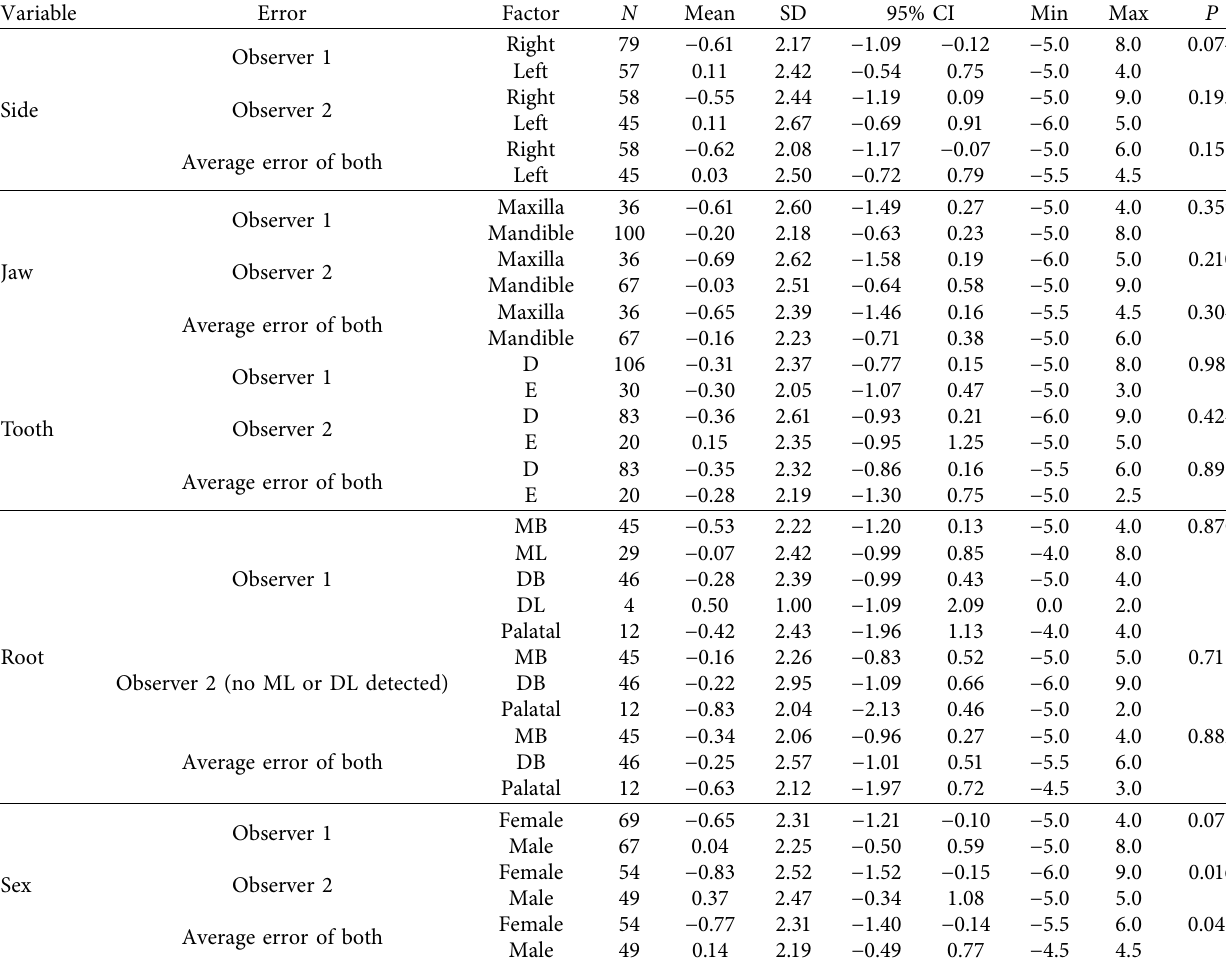
Table 3: Descriptive statistics and 95% CIs for the extents of error (mm, calculated as the actual resorption minus the radiographic resorption estimate) on different sides and in different jaws, teeth, and roots. The P values are calculated using the unpaired t -test and one- way